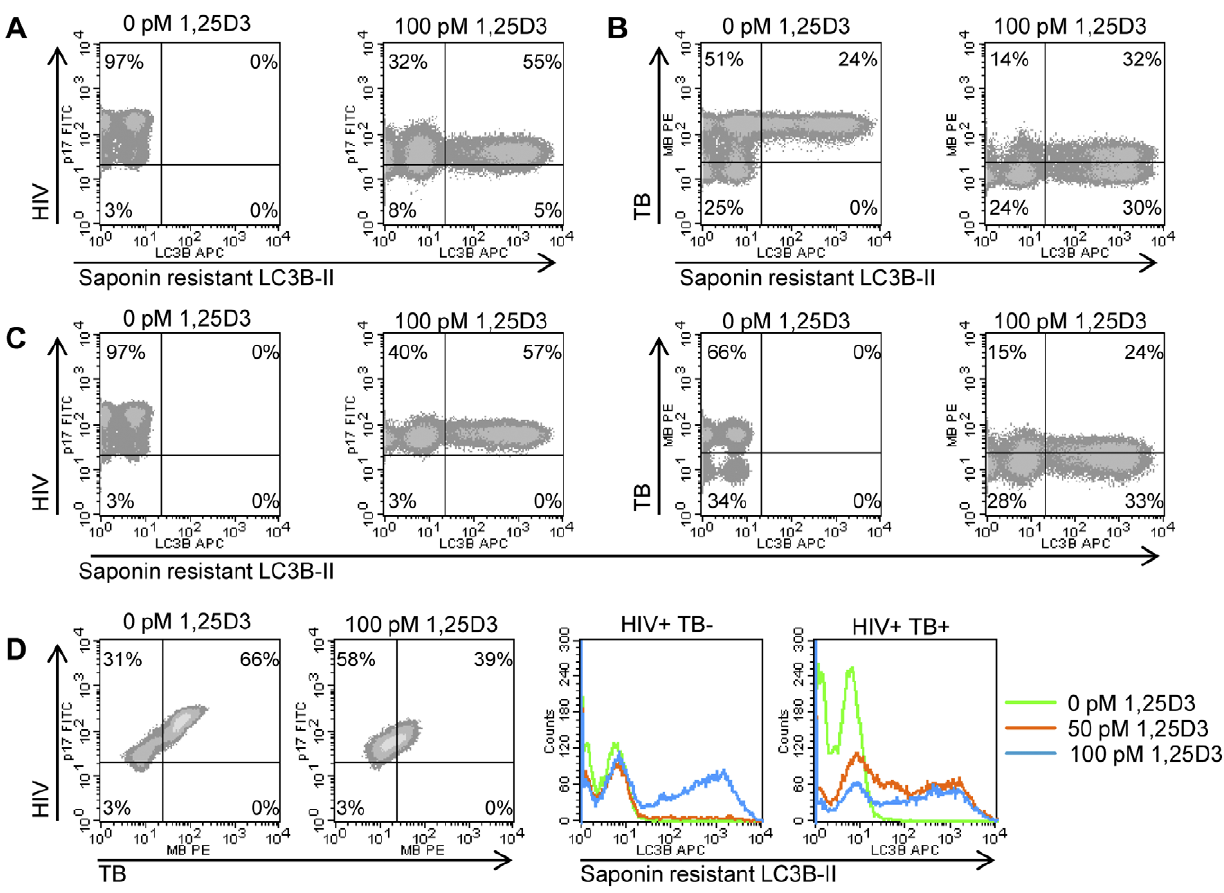
Figure 3. 1,25D3 induces autophagy in human macrophages co-infected with HIV and M.tuberculosis . HIV (A), M. tuberculosis (TB) (B), and HIV/TB dual infected MDM (C) were treated for 7 days with 100 pmol/L 1,25D3, harvested and stained for HIV p17, mycobacteria, and saponin- resistant LC3B-II. Representative density plots from three donors are shown. (D) HIV/ M. tuberculosis infected MDM (C) were treated for 7 days with 100 pmol/L 1,25D3, harvested and stained for HIV p17, mycobacteria, and saponin-resistant LC3B-II. Left, representative density plots from three donors from HIV/ M. tuberculosis infected MDM are shown for HIV/ M. tuberculosis co-infection. Right, histograms of saponin-resistant LC3B-II in macrophages that were HIV + M. tuberculosis 2 or HIV + M. tuberculosis + at day 7